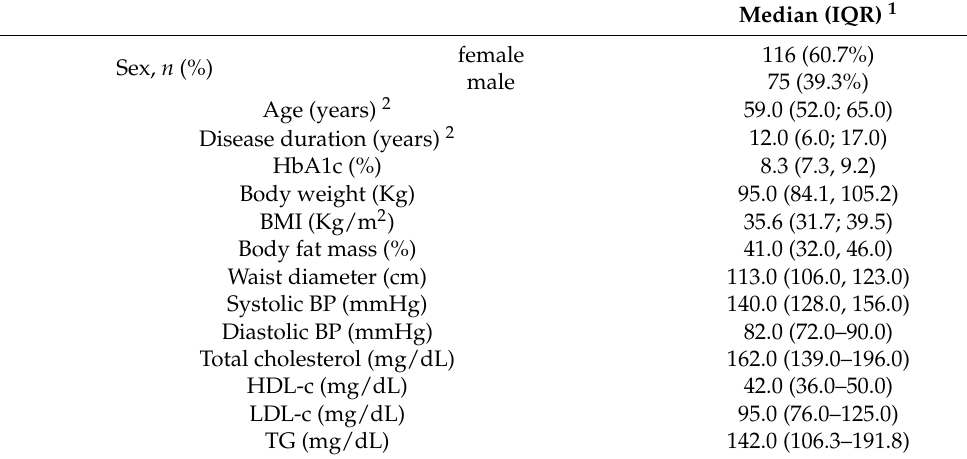
Table 1. Patient demographics and baseline characteristics.